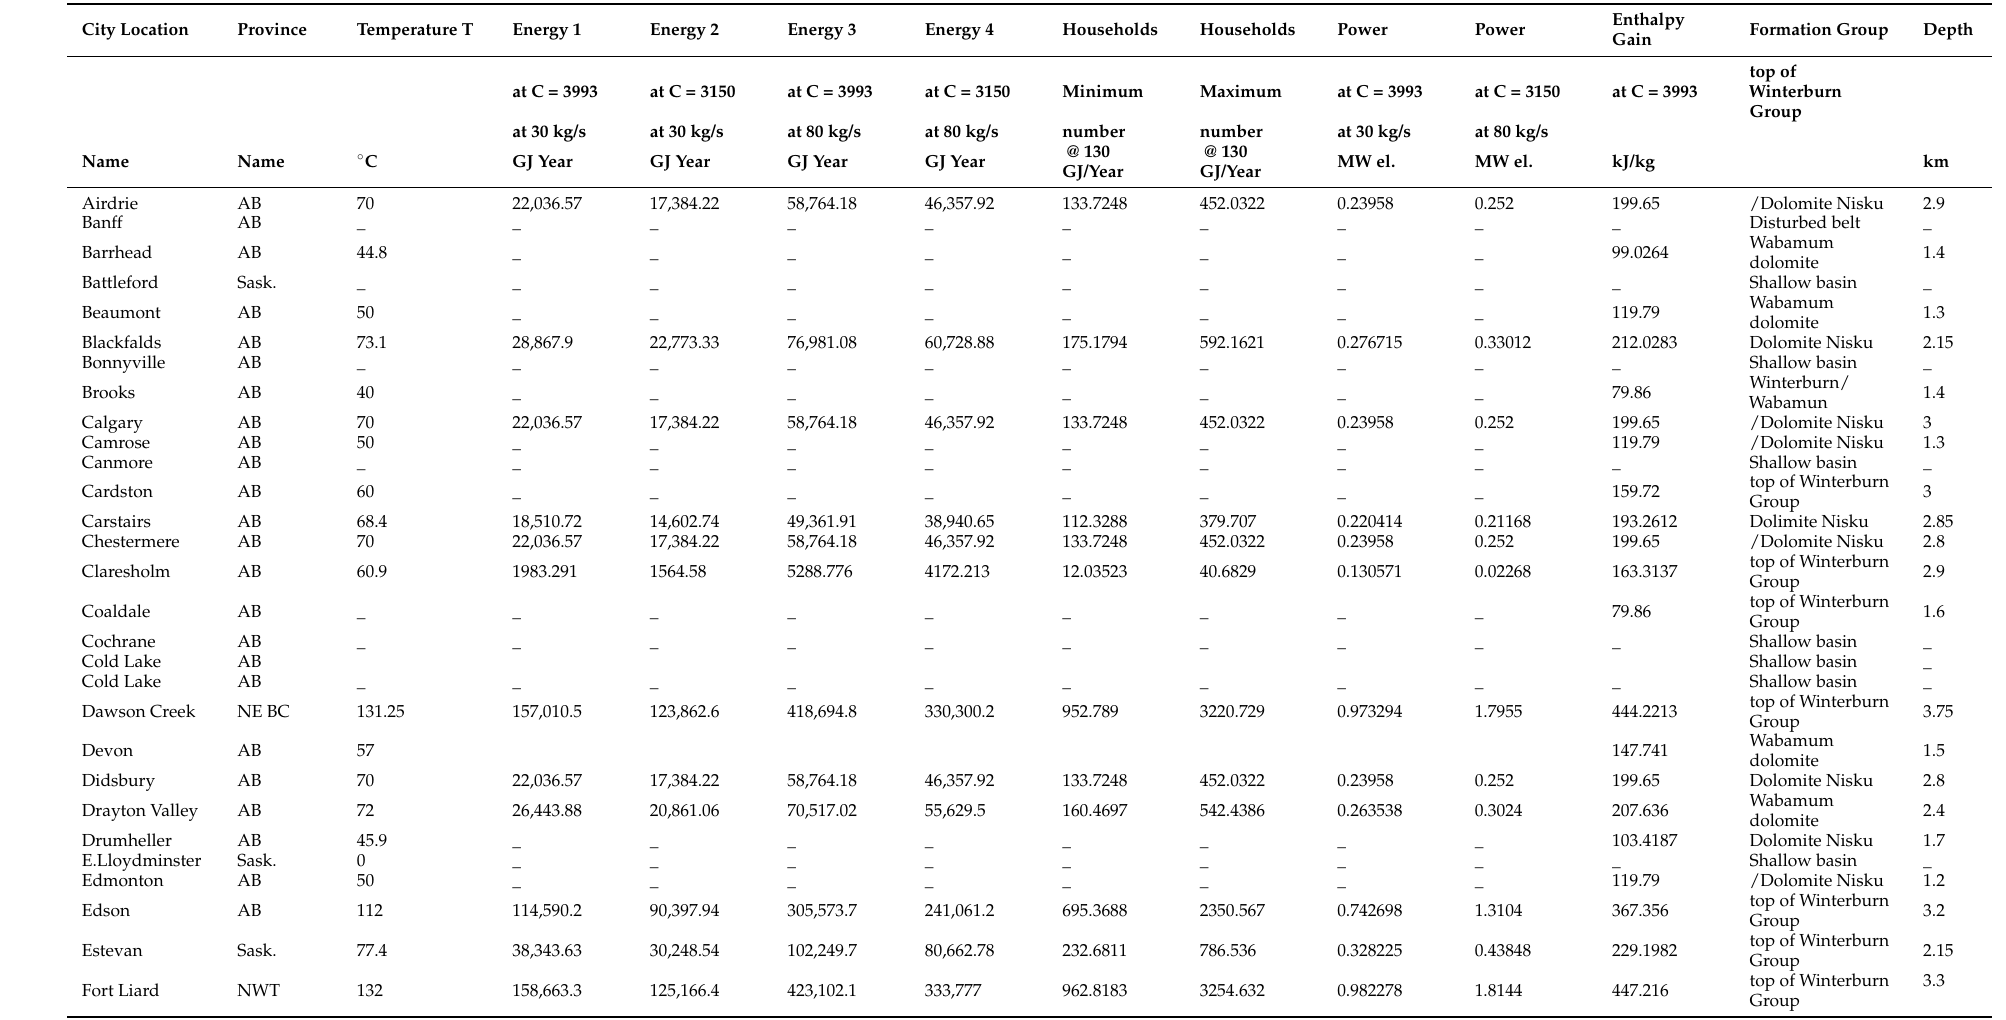
Table A3. WCSB >3 k populations centers geothermal prospects summary—Winterburn/Wabamun Groups—Energy, Enthalpy, Power, Number of direct deep geothermal energy heated households